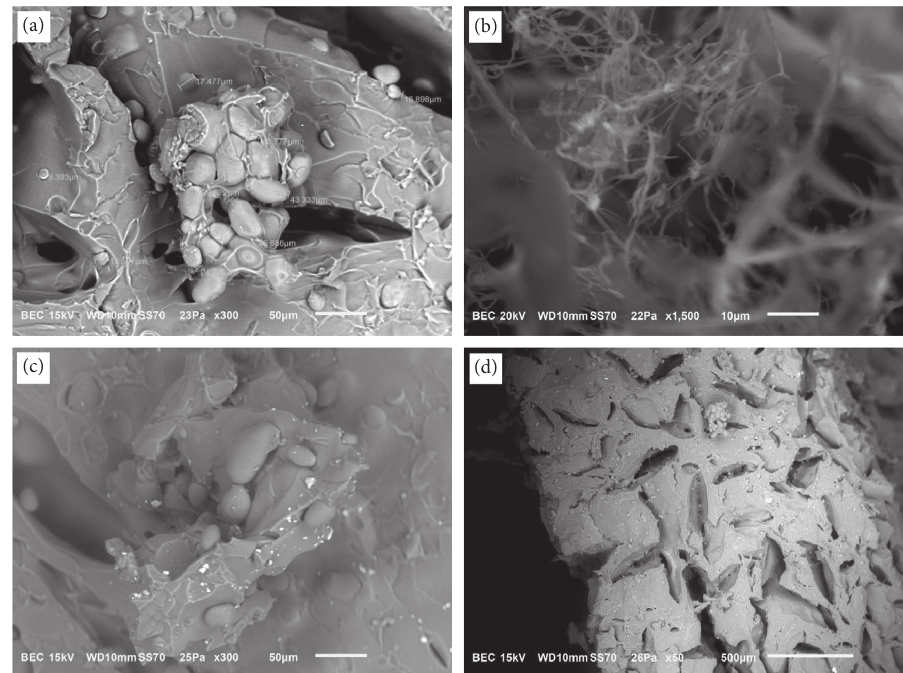
Figure 7: SEM micrographs of cross-sections of PAAm/starch dry hydrogels (50/50): (a) drug-free composite hydrogel at 50 μ m; (b) drug- free composite hydrogel at 10 μ m; (c) amoxicillin-loaded composite hydrogel at 50 μ m; (d) amoxicillin-loaded composite hydrogel at 500 μ